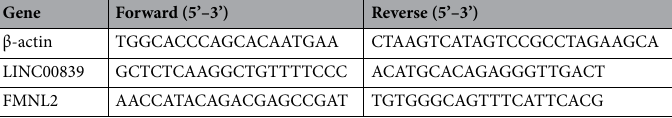
Table 1. Primer sequences for